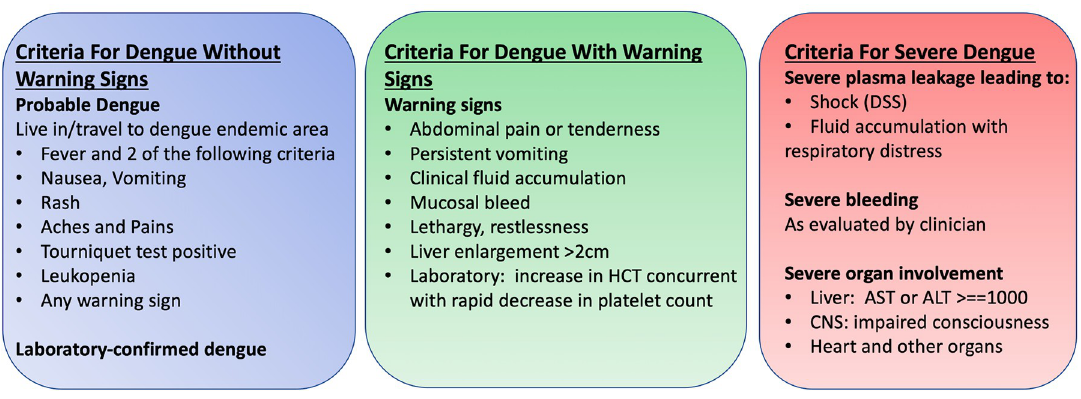
Fig 1. World Health Organization (WHO) dengue classification (2009).